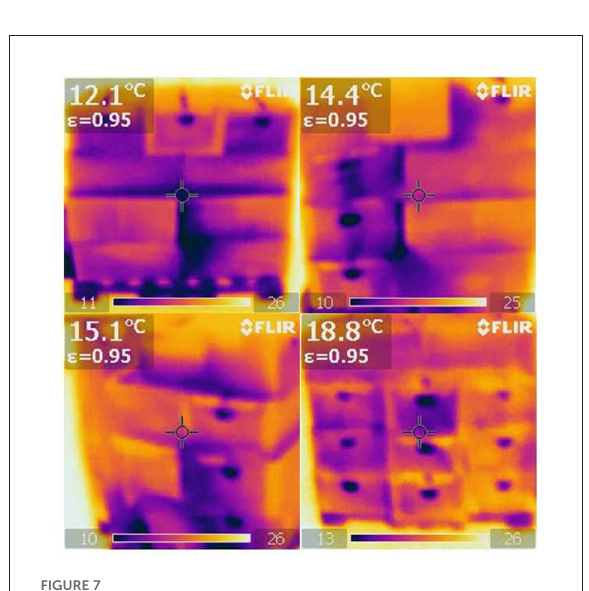
temperature recording because of the different levels of abuse experienced by different